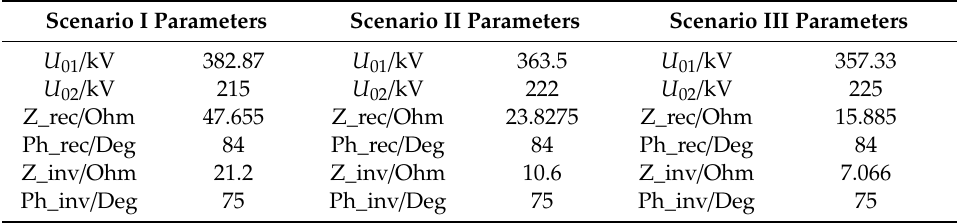
Table 2. Simplified ac system equivalent Thevenin circuit